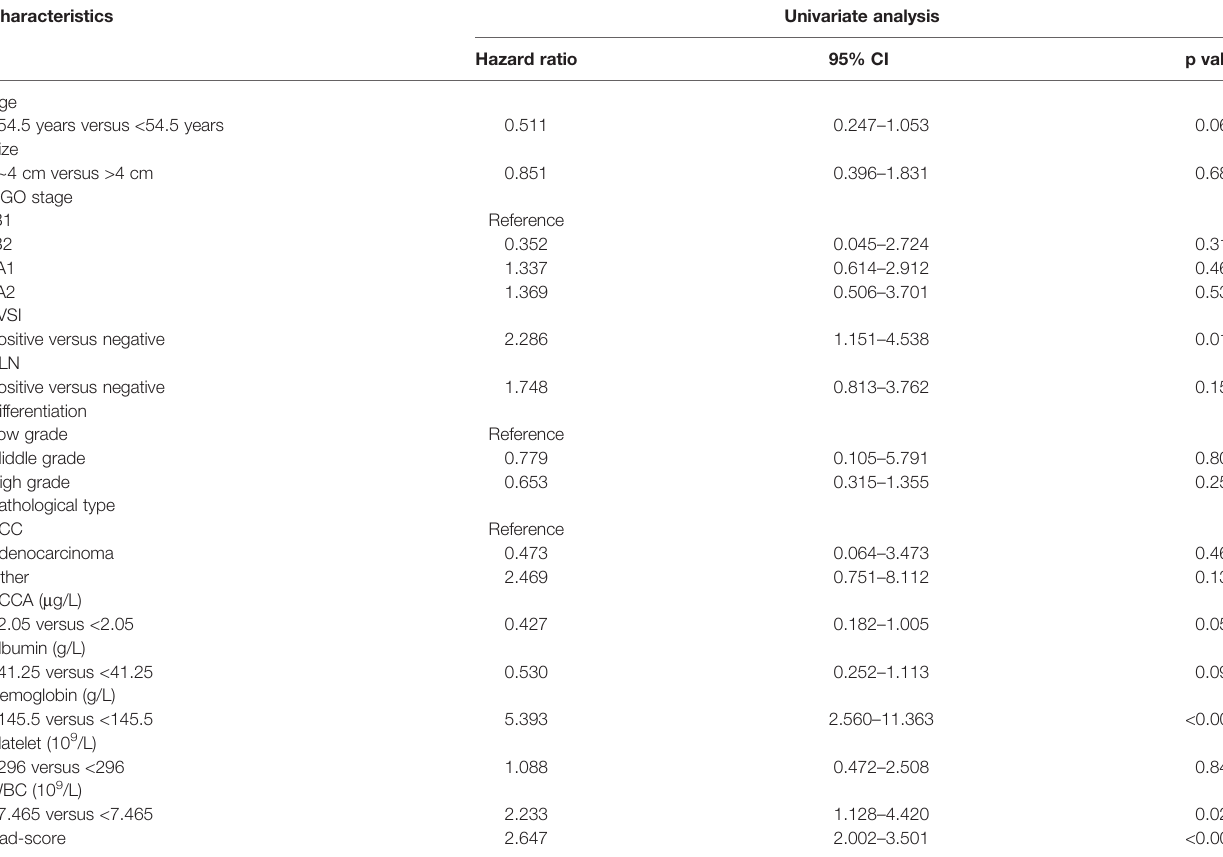
PFS, progression-free survival; FIGO, International Federation of Gynecology and Obstetrics; LVSI, lymph vascular space invasion; LNM, lymph node metastasis; SCC, squamous cell carcinoma; SCCA, squamous cell carcinoma antigen; WBC, white blood cell; CI, con fi dence